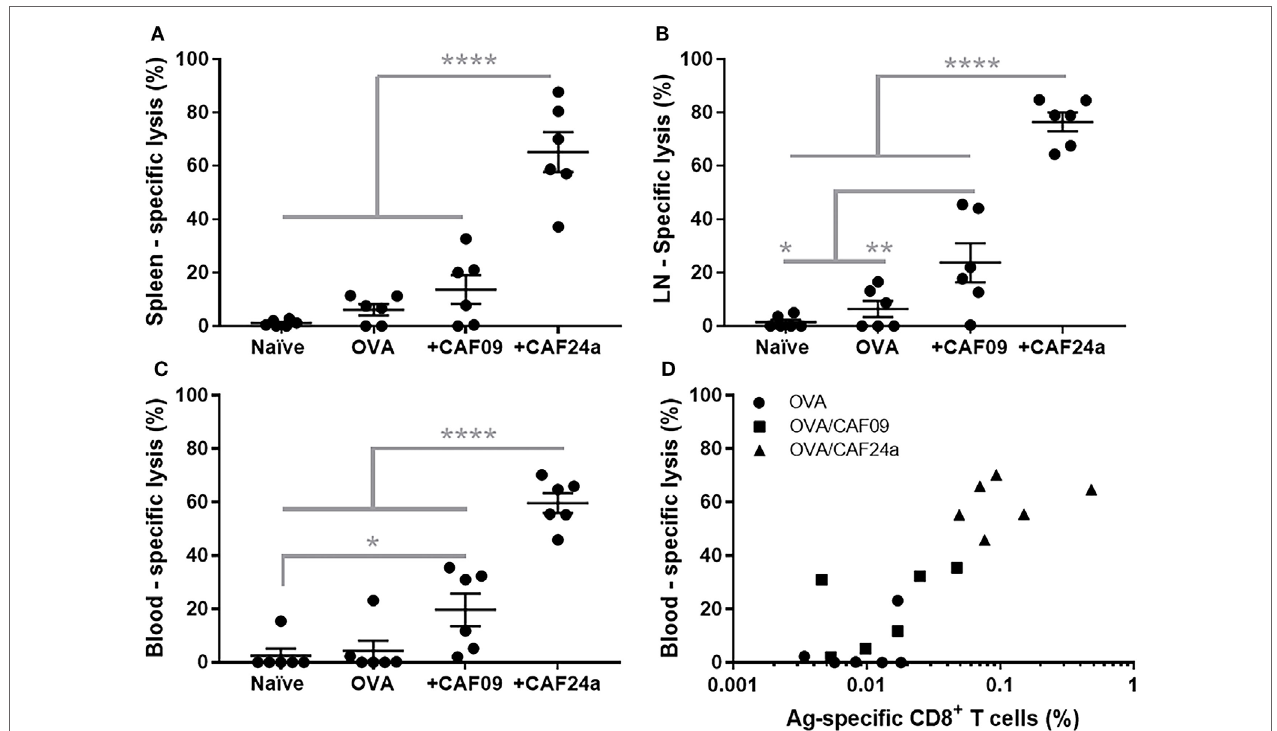
FigUre 5 | Specific lysis of SIINFEKL-loaded splenocytes 24 h after intravenous injection in (a) spleen, (b) draining lymph nodes, and (c) blood in naïve mice and following subcutaneous immunization with 1 μ g/dose OVA, OVA/cationic adjuvant formulation (CAF)09, and OVA/CAF24a, respectively. (D) Comparison of the levels of SIINFEKL-specific CD8 + T cells and the specific lysis in the blood in individual mice. Correlation for the combined groups: Spearman, p = 0.0001. The results are from one of two repeated studies. n = 6, lines with bars represent mean ± SEM. * p ≤ 0.05, ** p ≤ 0.01, **** p ≤ 0.0001, one-way ANOVA with Tukey’s